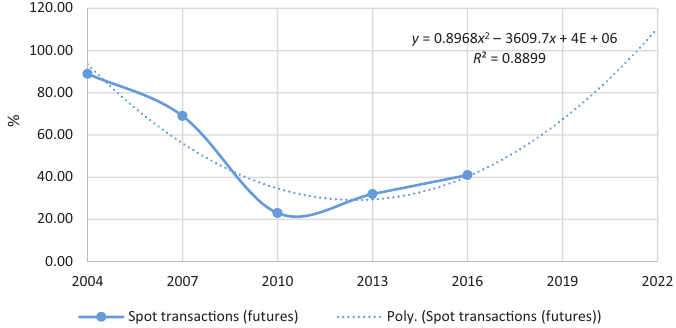
Figure 9. Forecast of spot transactions (futures) based on factual data and applying a polynomial function (source: developed by the authors based on LB, 2016, 2018, 2019b; BIS, 2018a, 2018b)